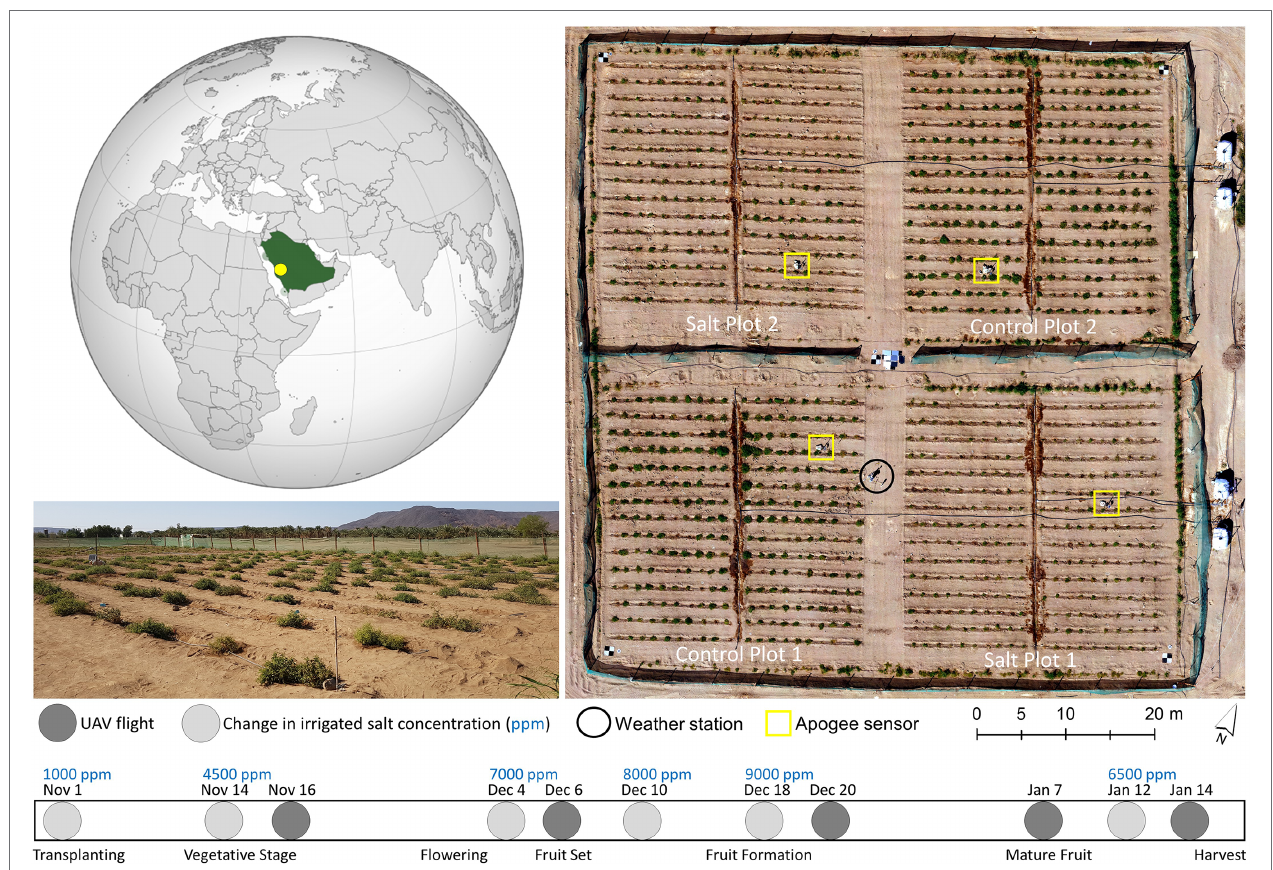
FIGURE 1 | Left: The location of the tomato field experiment and a field photograph of Salt Plot 2 at the King Abdulaziz University Agricultural Research Station, Hada Al-Sham, Saudi Arabia (21 ° 47 ʹ 48 ʺ N, 39 ° 43 ʹ 35 ʺ E). Right: A UAV-derived orthomosaic of the site captured on January 14, 2018, showing the trial layout. Bottom: The timing of UAV flights, tomato phenological stages, and concentrations of salt in parts per million (ppm) in the water used to irrigate the salt-treated plots across the growing